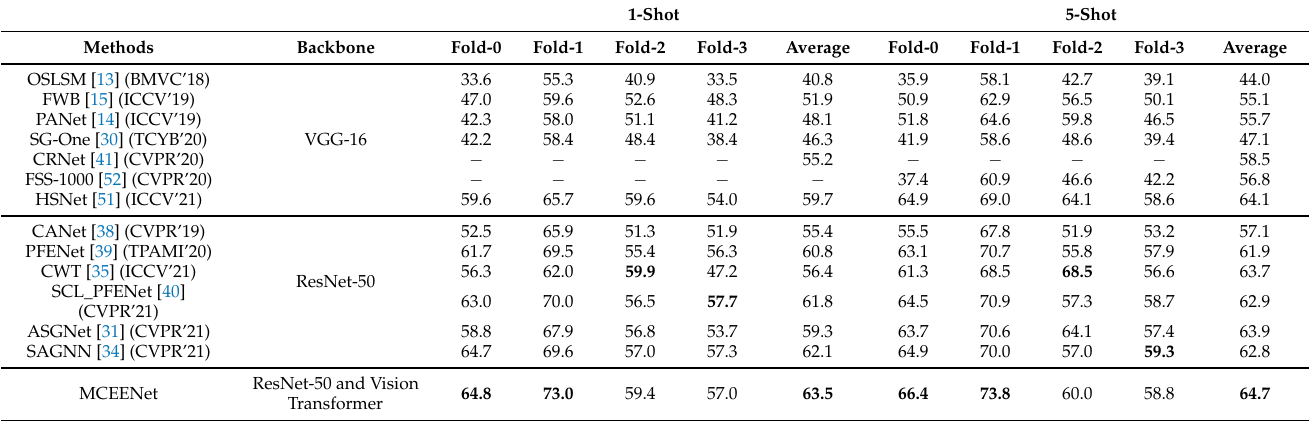
Table 3. Results of MCEENet and other state-of-the-art FSS methods on four folds of the PASCAL-5 i dataset in terms of mIoU. The highest performance in each column is highlighted in